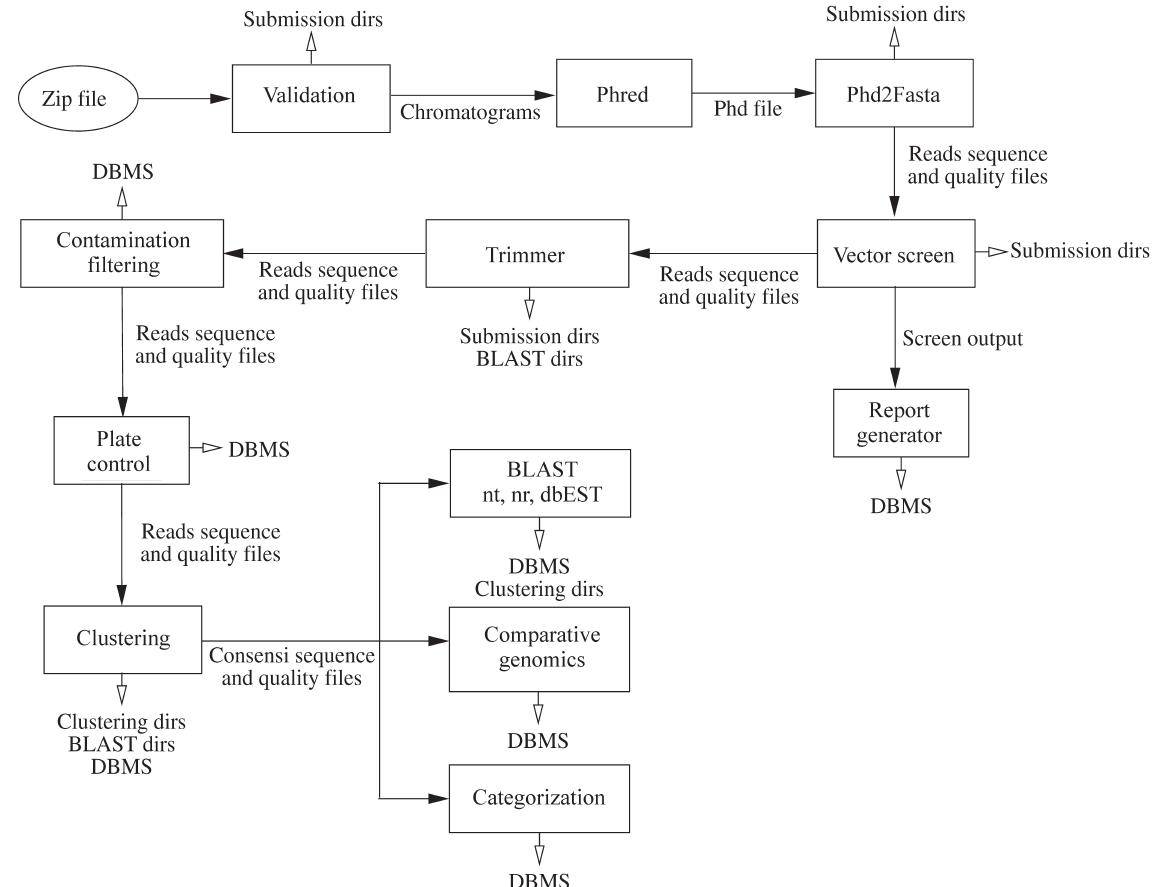
Figure 2 - The operations taking place on a read in the SUCEST pipeline. Black arrows linking boxes indicate data that flow from one stage to the next while white-headed arrows going out of boxes indicate date repository